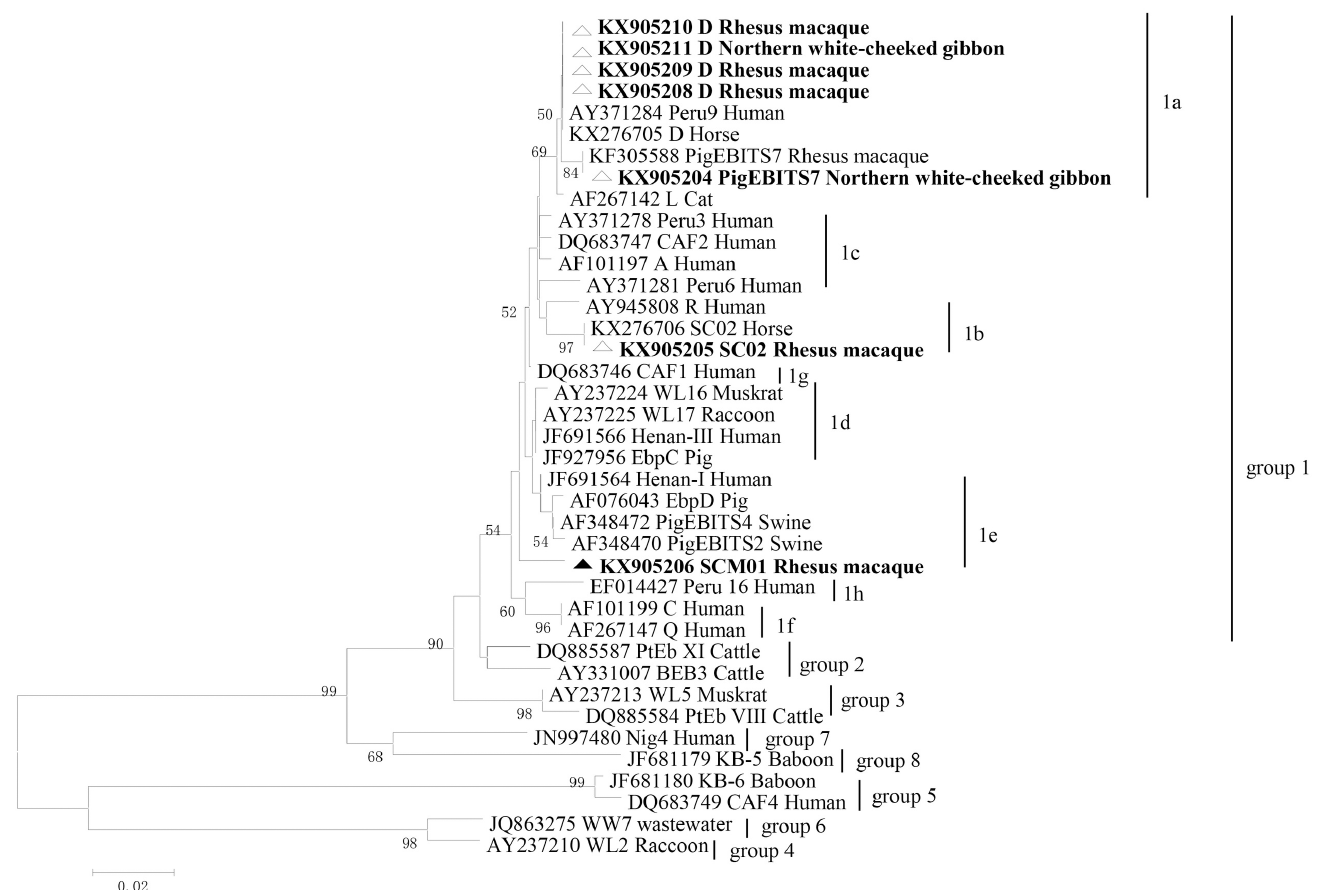
Fig 1. Phylogenetic relationships of ITS nucleotide sequences of the E . bieneusi genotypes identified in this study and other reported genotypes. The phylogeny was inferred by a neighbor-joininganalysis. Bootstrap values were obtainedusing 1,000 pseudo-replicates and greater than > 50% was shown on nodes. The genotypesin this study are marked by trianglesand the novel genotypes are marked by full